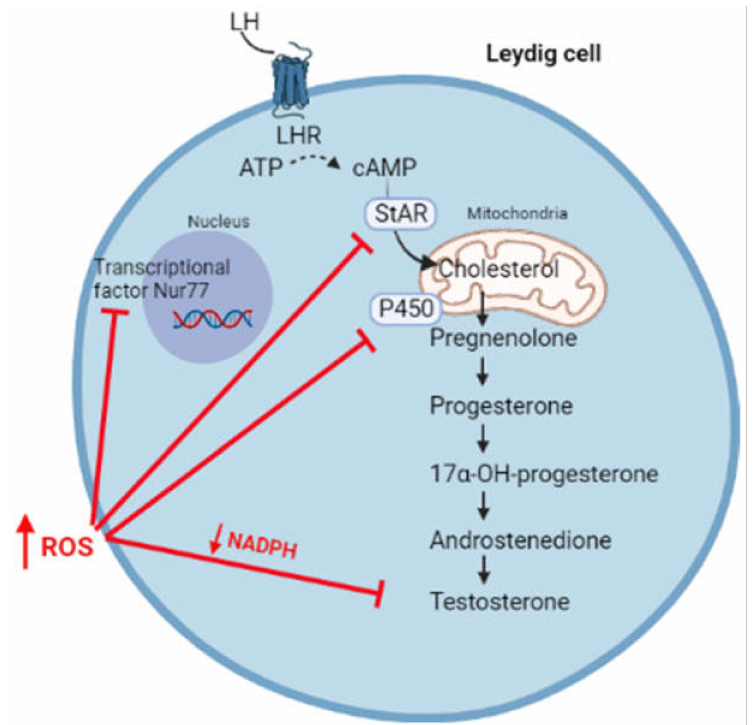
Figure 3. High levels of ROS affect steroidogenesis through the inhibition of transcriptional factor Nur77, the synthesis of StAR, enzymatic P450 activity, and by reducing the levels of NADPH